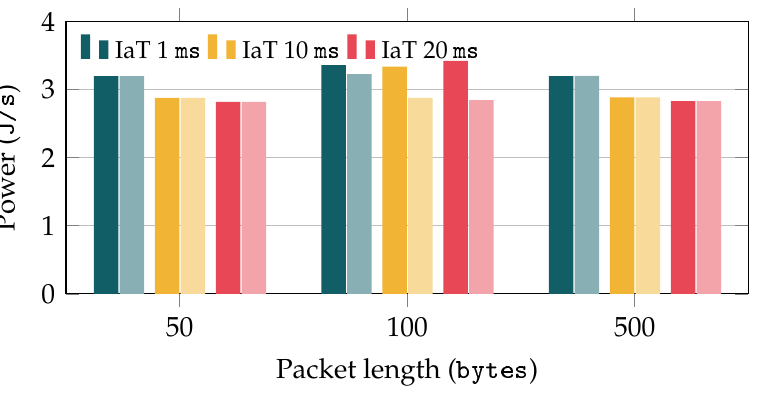
Figure 10. Power consumption of QUIC (left dark bars) and TCP (right pale bars) for different packet lengths and inter-arrival-times